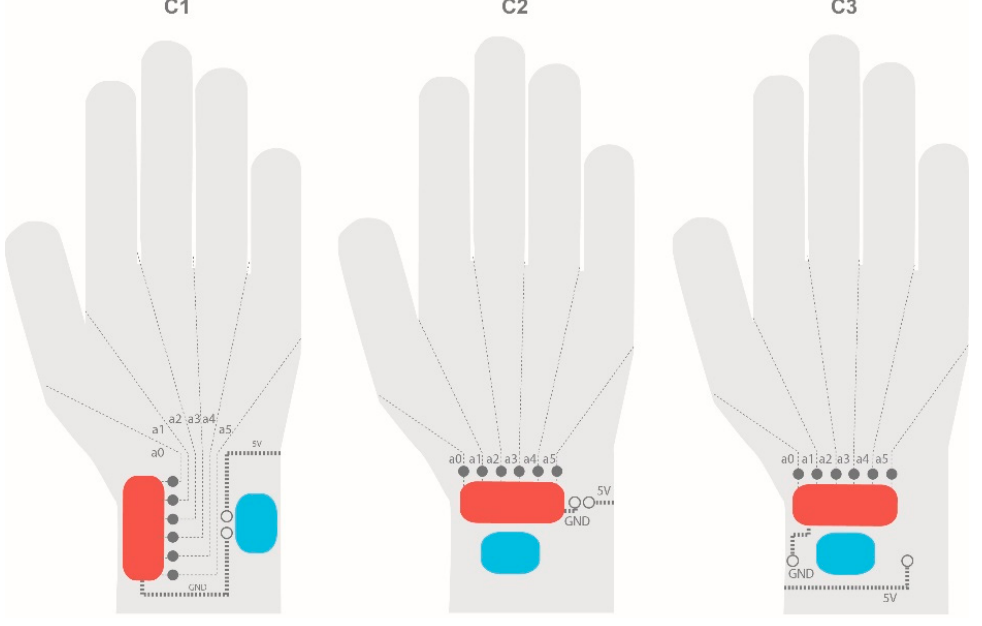
Figure 7. Different component arrangements and circuits for the selected case C based on components orientation.